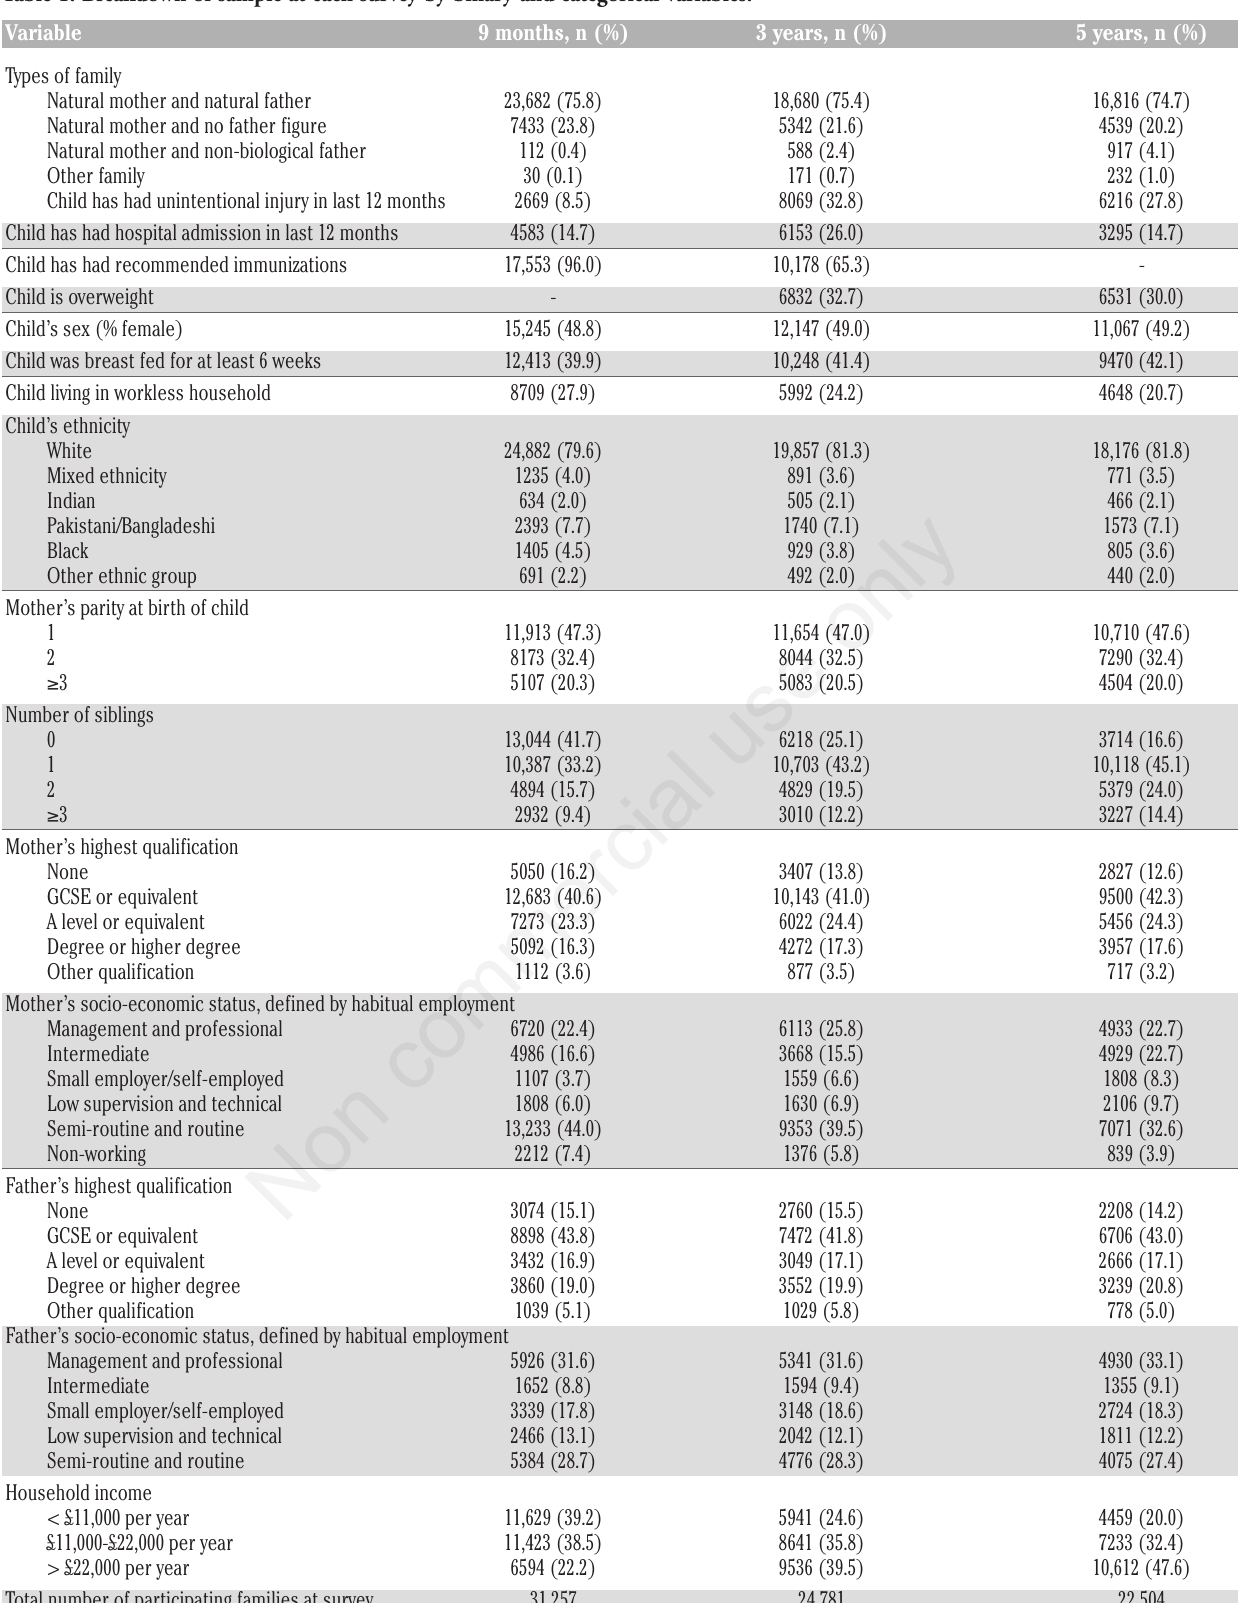
Table 1. Breakdown of sample at each survey by binary and categorical variables.